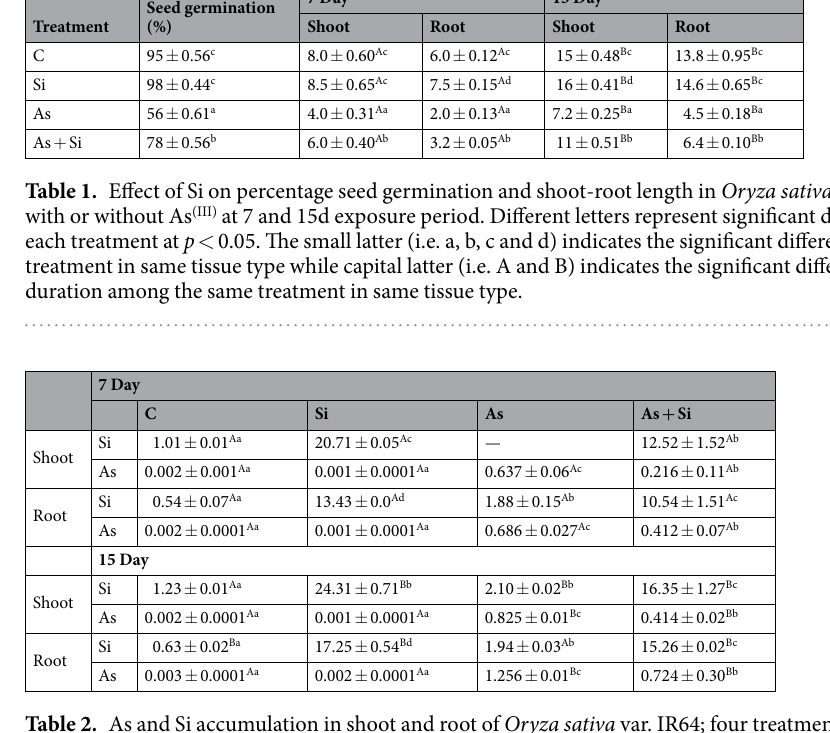
Table 2. As and Si accumulation in shoot and root of Oryza sativa var. IR64; four treatments were used (C-control, 150 µ M As (III) , 5 mM Si, 150 µ M As (III) + 5 mM Si). The data represented as an average of three replicates and repeated twice. Different letters represent significant differences between each treatment at p < 0.05. The small latter (i.e. a, b, c and d) indicates the significant difference between treatment in same tissue type while capital latter (i.e. A and B) indicates the significant difference between duration among the same treatment in same tissue